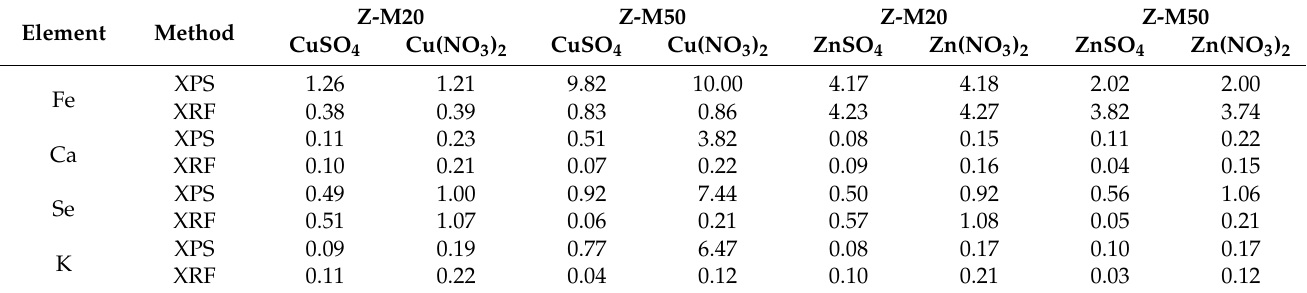
Table 8. A comparison of elemental content ratio of Cu or Zn to other elements after sorption.